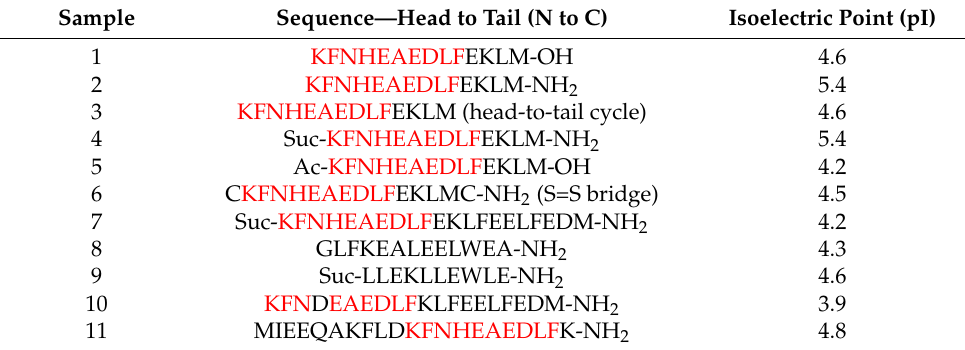
Table 1. Synthetic peptide sequences and calculated isoelectric points for each sample.